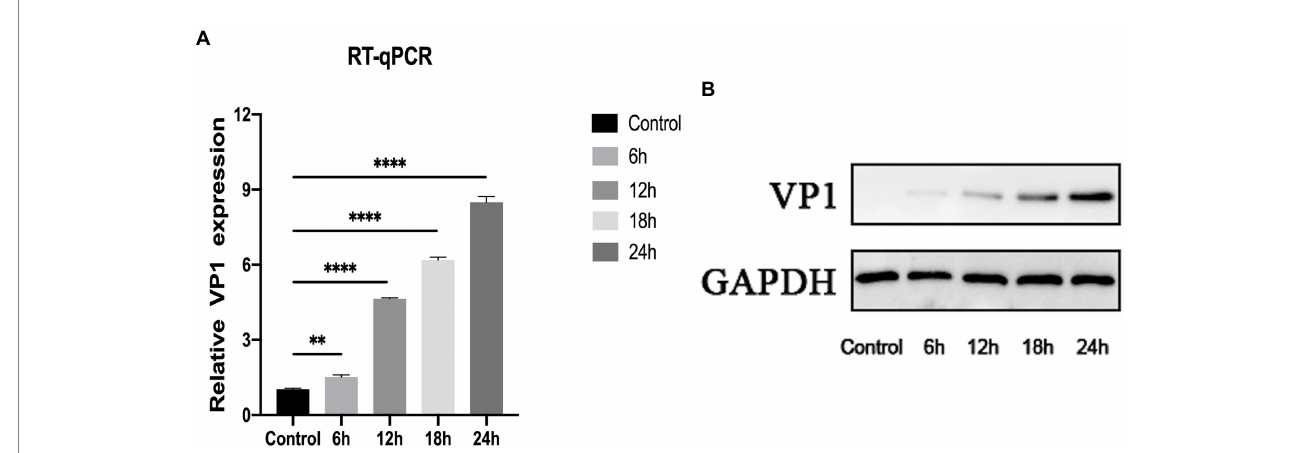
FIGURE 1 Construction of EV-D68 infected cell model. (A) The relative expression level of viral VP1 was determined using quantitative reverse transcription polymerase chain reaction (qRT-PCR). Rhabdomyosarcoma (RD) cells were infected with EV-D68 for 0, 6, 12, 18, and 24 h respectively, and the total RNA was extracted. (B) The expression level of viral VP1 was determined by western blot. The total protein in RD cells was collected, which had been infected with EV-D68 for 0, 6, 12, 18, and 24 h, respectively (** p < 0.01, **** p <